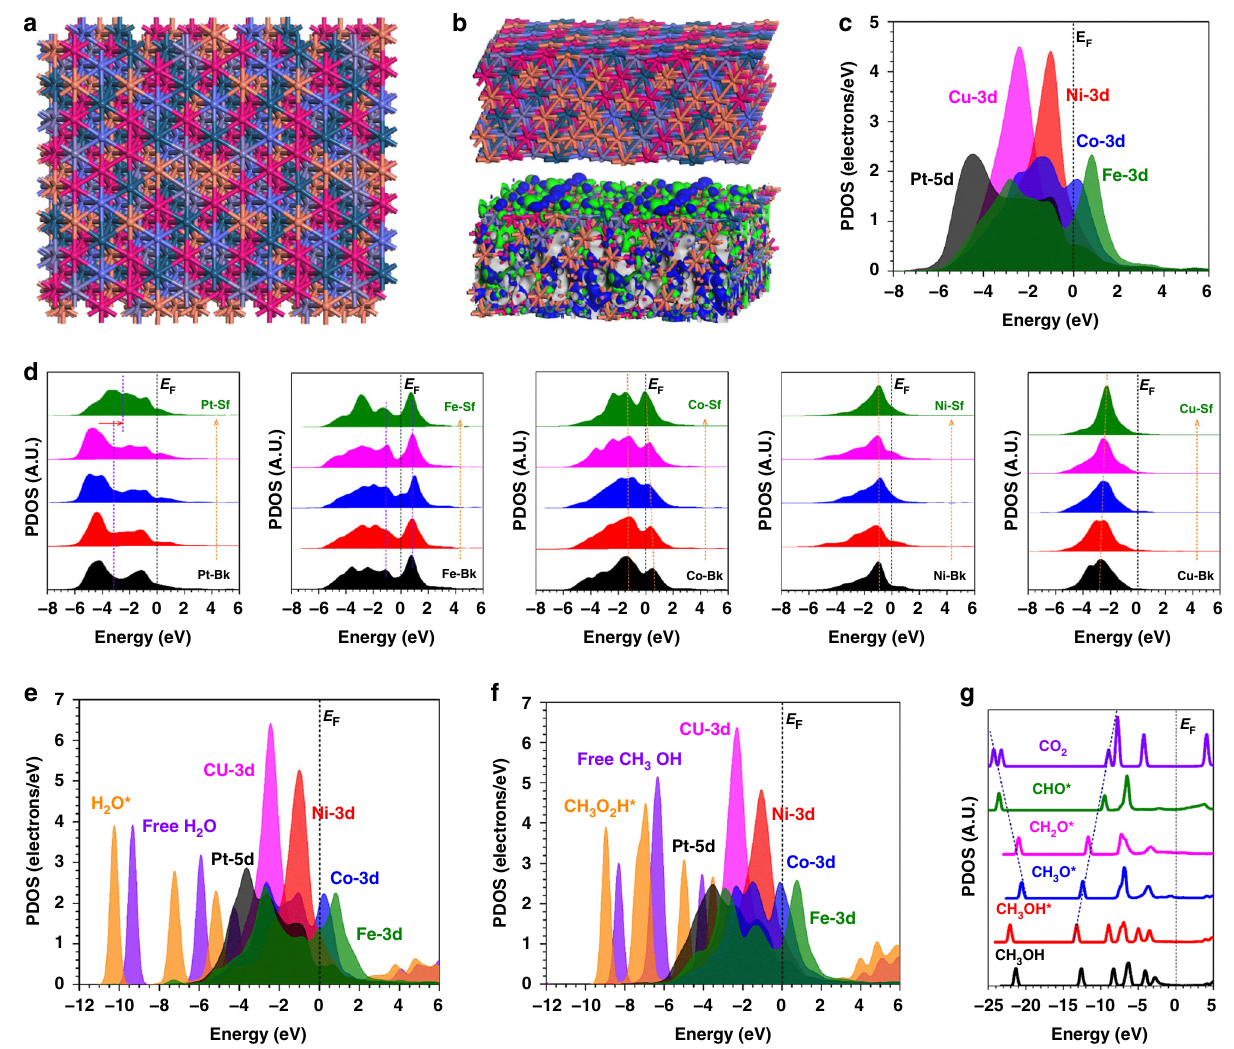
Fig. 4 Density functional theory calculations for the structural con fi guration and PDOSs. a The side view of the structural con fi guration of HEA. b The side view of HEA structural con fi guration and the real spatial contour plots for bonding and anti-bonding orbitals near E F . And the top view of the real spatial contour plots for bonding and anti-bonding orbitals near E F for the HEA. Dark green balls = Pt; Gray balls = Fe; Blue balls = Co; Pink balls = Ni and Orange balls = Cu. c The PDOSs of the HEA. d The site-dependent PDOSs of Pt, Fe, Co, Ni, and Cu in HEA. e The PDOSs for the water adsorption. f The PDOSs for the CH 3 OH adsorption. g The PDOSs for the key intermediates of